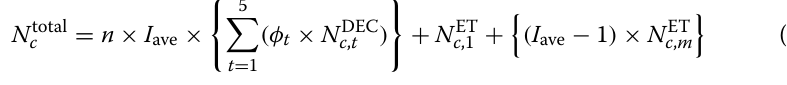
Table 4 The usage number of four arithmetic operators per decoding of a single row/column vector required in the error correction of the proposed syndrome-based decoding algorithm (reference to Fig. 1) Addition Multiplication N DEC c , t